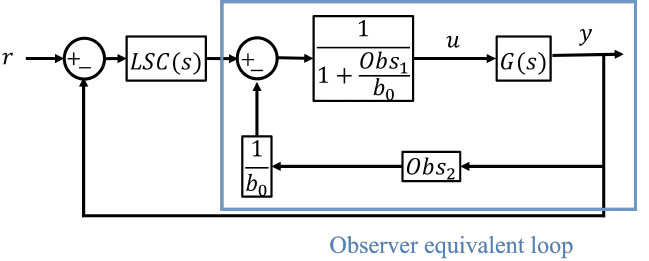
Figure 9. Equivalent representation of the LADRC + LSC , considering the transformation of the observer into a transfer function